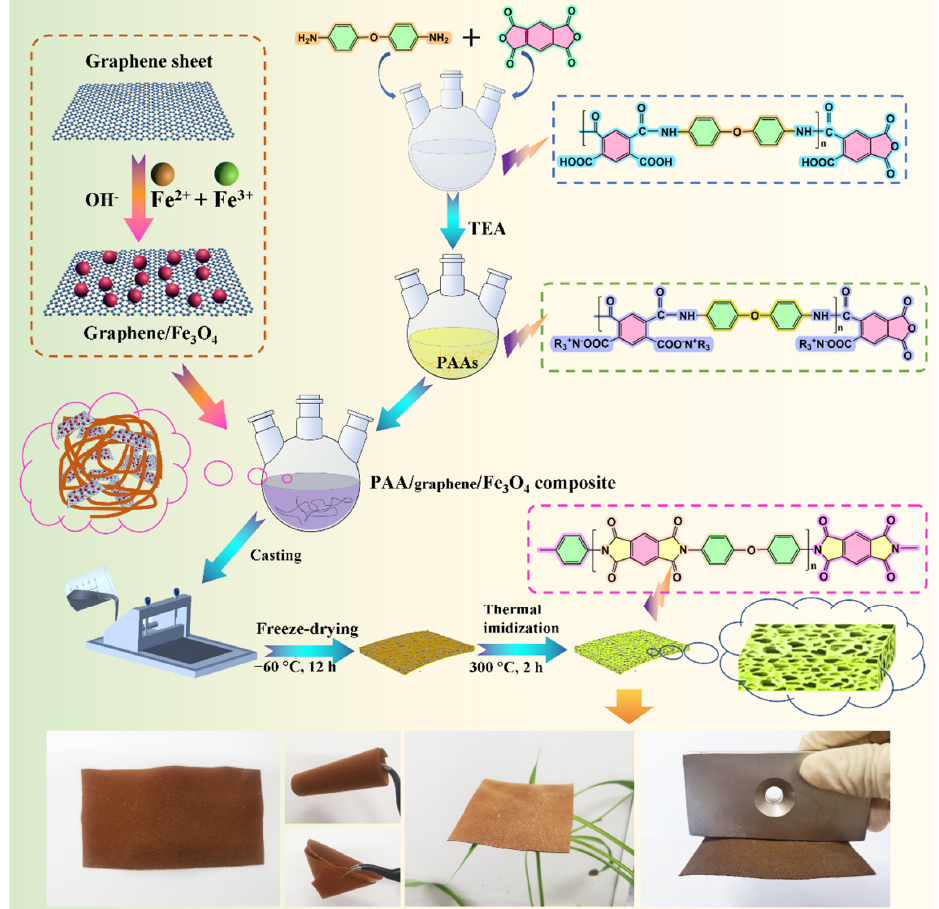
Figure 1. Scheme of fabrication methods and reaction mechanisms of PI/graphene/Fe 3 O 4 hybrid aerogel film and PI/graphene/Fe 3 O 4 aerogel/PEG composite film as well as the digital photos of PI/graphene/Fe 3 O 4 hybrid aerogel film.